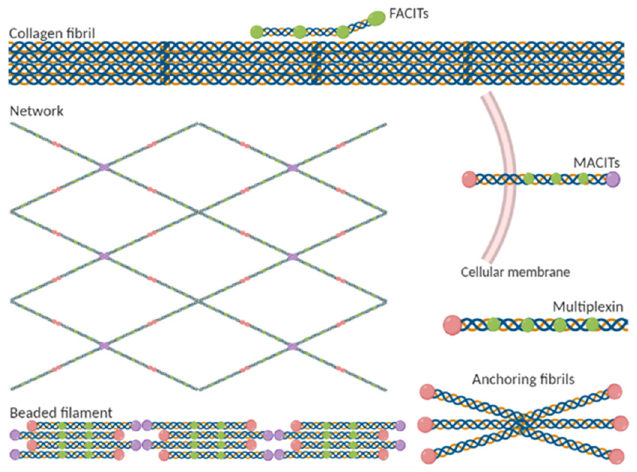
Figure 3. Classification of collagen types based on their structural and organisation.